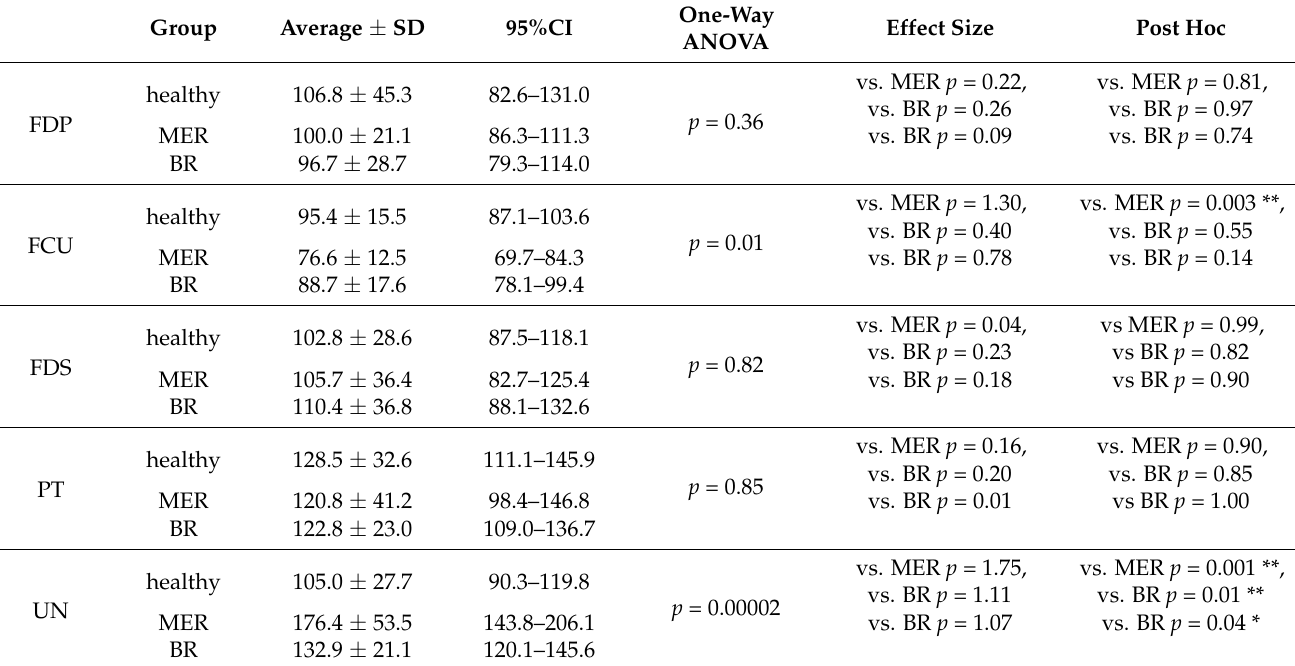
Table 4. Comparison of rest CSA between the three groups.